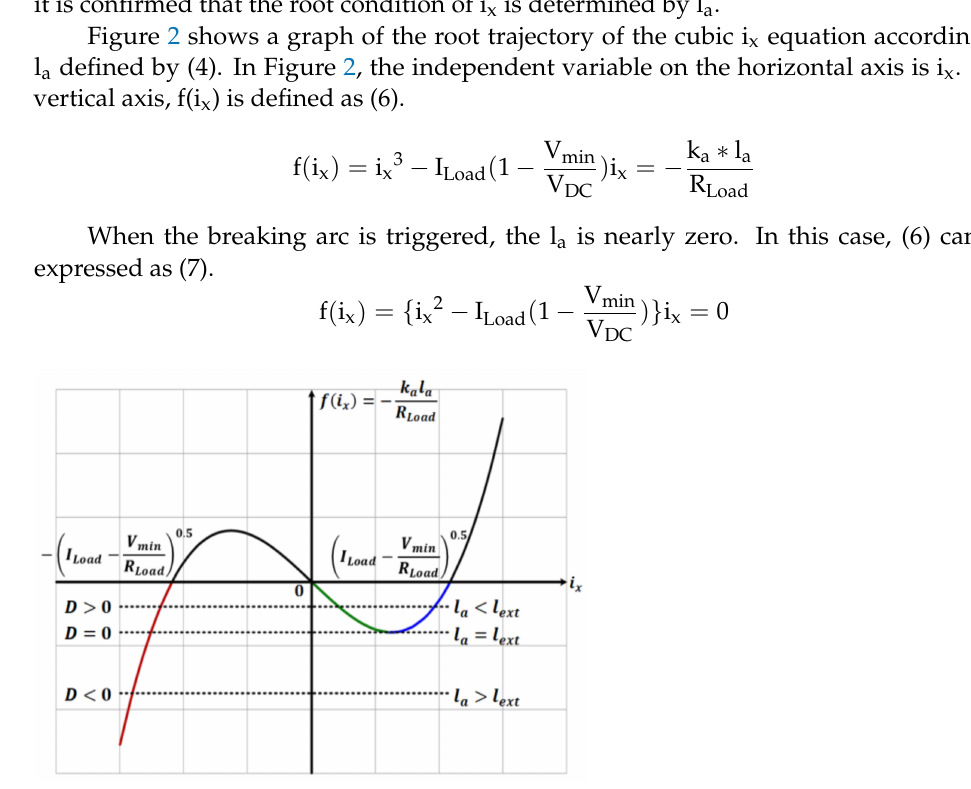
Figure 2. Root condition of i x according to separation distance between both